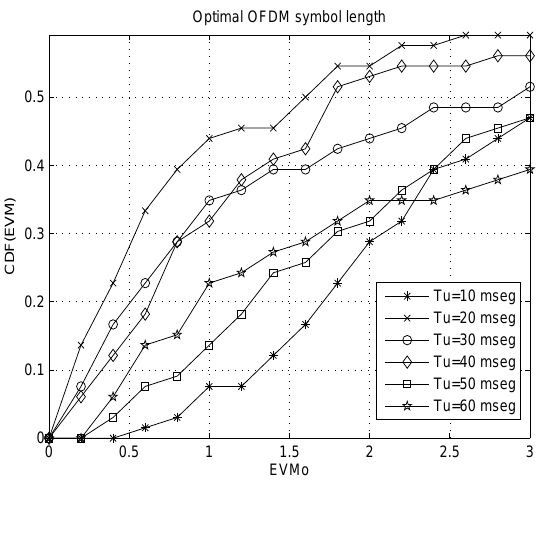
Figure 6. CDF of the EVM of received symbols gathered from the SAS-OE HF link. OFDM signals were transmitted at frequencies between 4.4 MHz and 17.6 MHz from 21 UTC to 09 UTC, during the 2006–2007 Antarctic